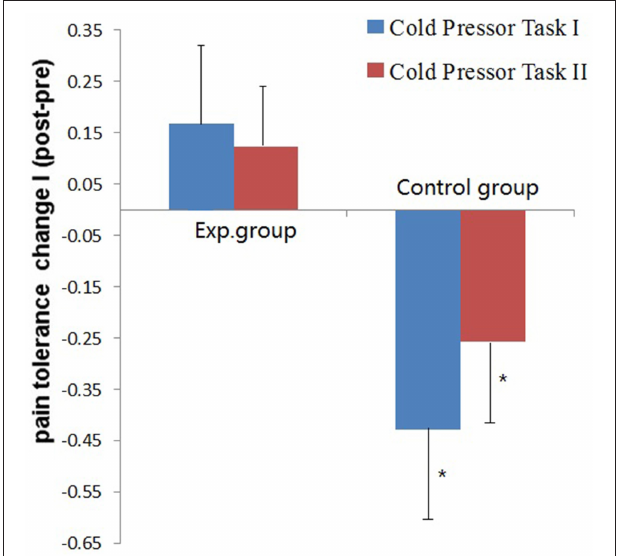
FIGURE 1 | Mean pain tolerance scores change and S.E.M. of the two groups (Exp. vs. Control group) in the two Cold Pressor Tasks. Pain tolerance was calculated by the Log e transformation of immersion duration in cold water. Change = Pain tolerance_ post − training – Pain tolerance_ pre − training. * p <